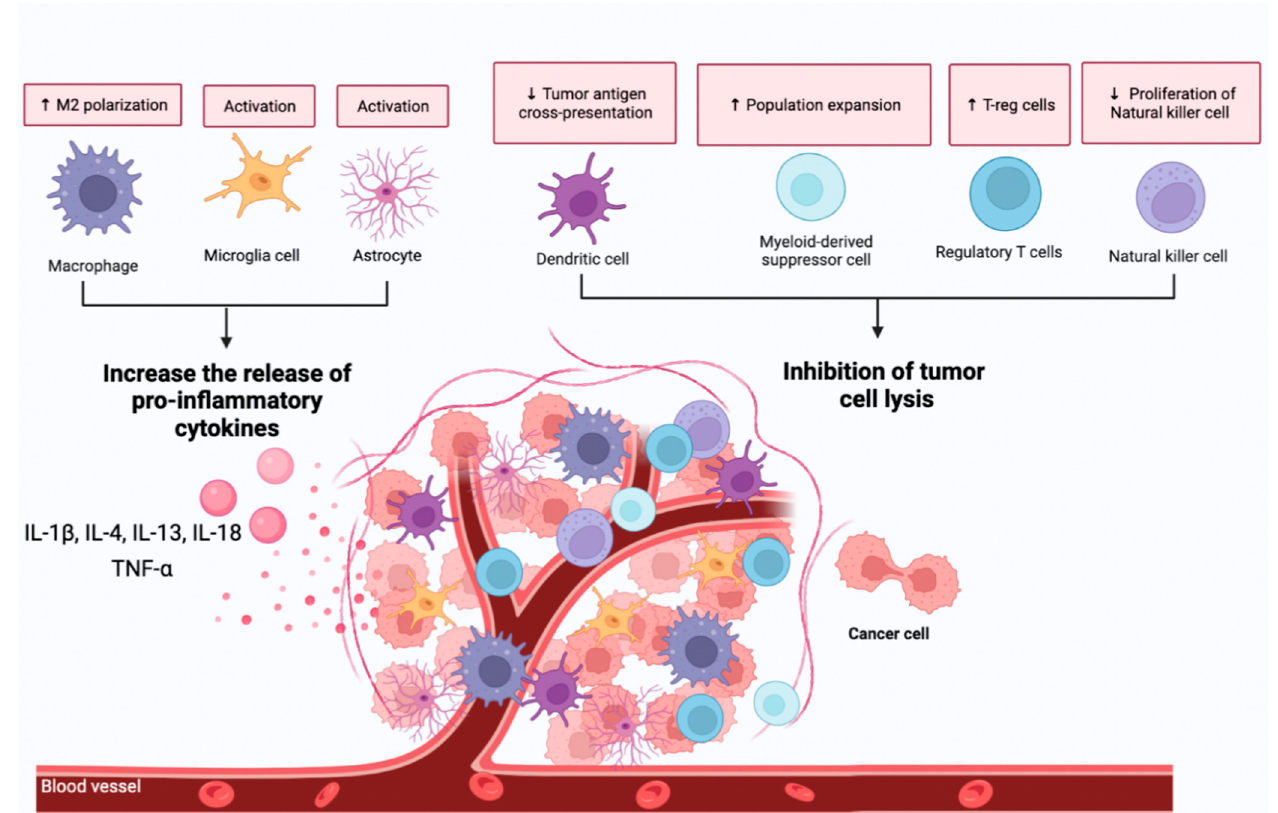
Figure 1. Immunosuppression in brain cancer. The increase of M2 macrophages, activation of microglia and astrogliosis promote a chronic systemic inflammatory environment associated with tumor development and metastasis. In addition, the evasion of the immune system by cancer cells creates an immunosuppressive environment that contributes to tumor growth. The mechanisms of immunosuppression are related to a reduction of the cytotoxic activity of dendritic cells and NK cells and to the increase of cells capable of reducing the activity of CD8+ T-cells such as T-reg and MDSC cells. The figure was created with the help of Biorender.com (accessed on 10 May 2022).